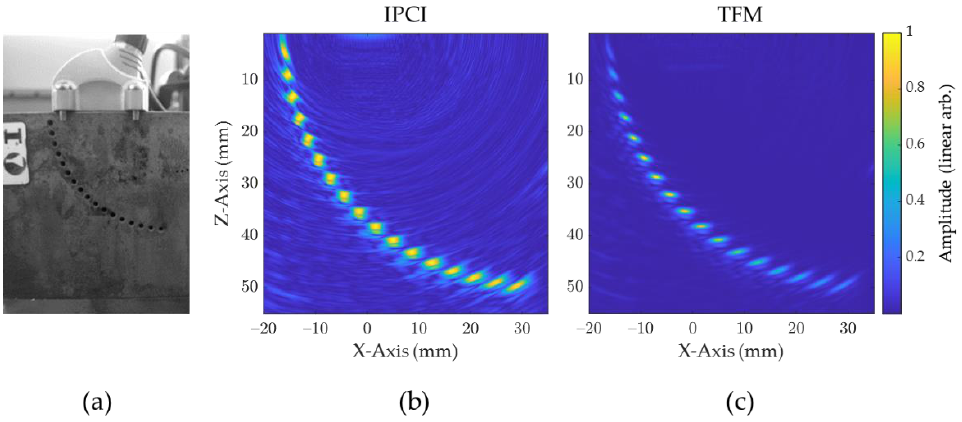
Figure 7. Experimental example of reconstructed defect consistency and attenuation robustness, using IPCI instead of TFM: ( a ) inspection setup composed of a 5 MHz (32 element) probe and an ASTM E2491 low-carbon steel test bloc; ( b ) reconstructed image of the sample obtained using IPCI; ( c ) reconstructed image of the sample obtained using TFM.